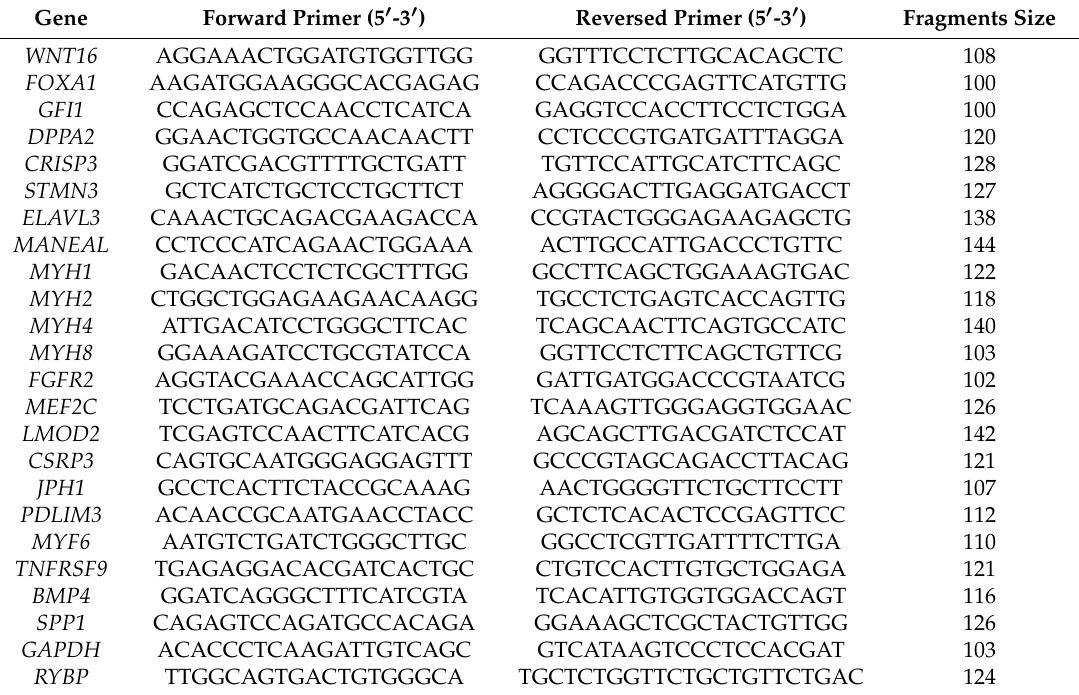
Table 1. Sequence information of the primers used for real-time